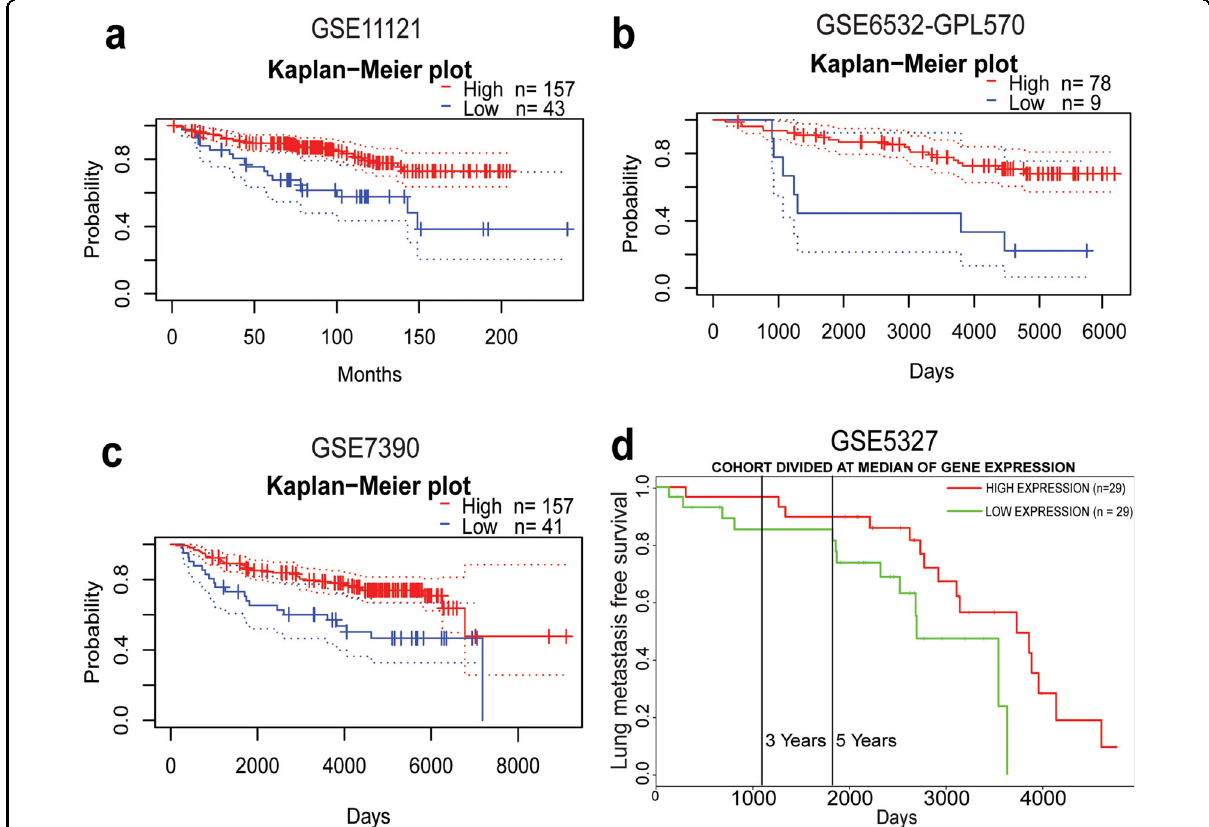
Fig. 1 TRIP12 expression in breast cancer patients correlates with distant metastasis-free survival. Kaplan – Meier distant metastasis-free survival curve for breast cancer patients in ( a ) GSE11121, b GSE6532-GPL570, c GSE7390, and ( d ) Kaplan – Meier lung metastasis-free survival curve for breast cancer patients in